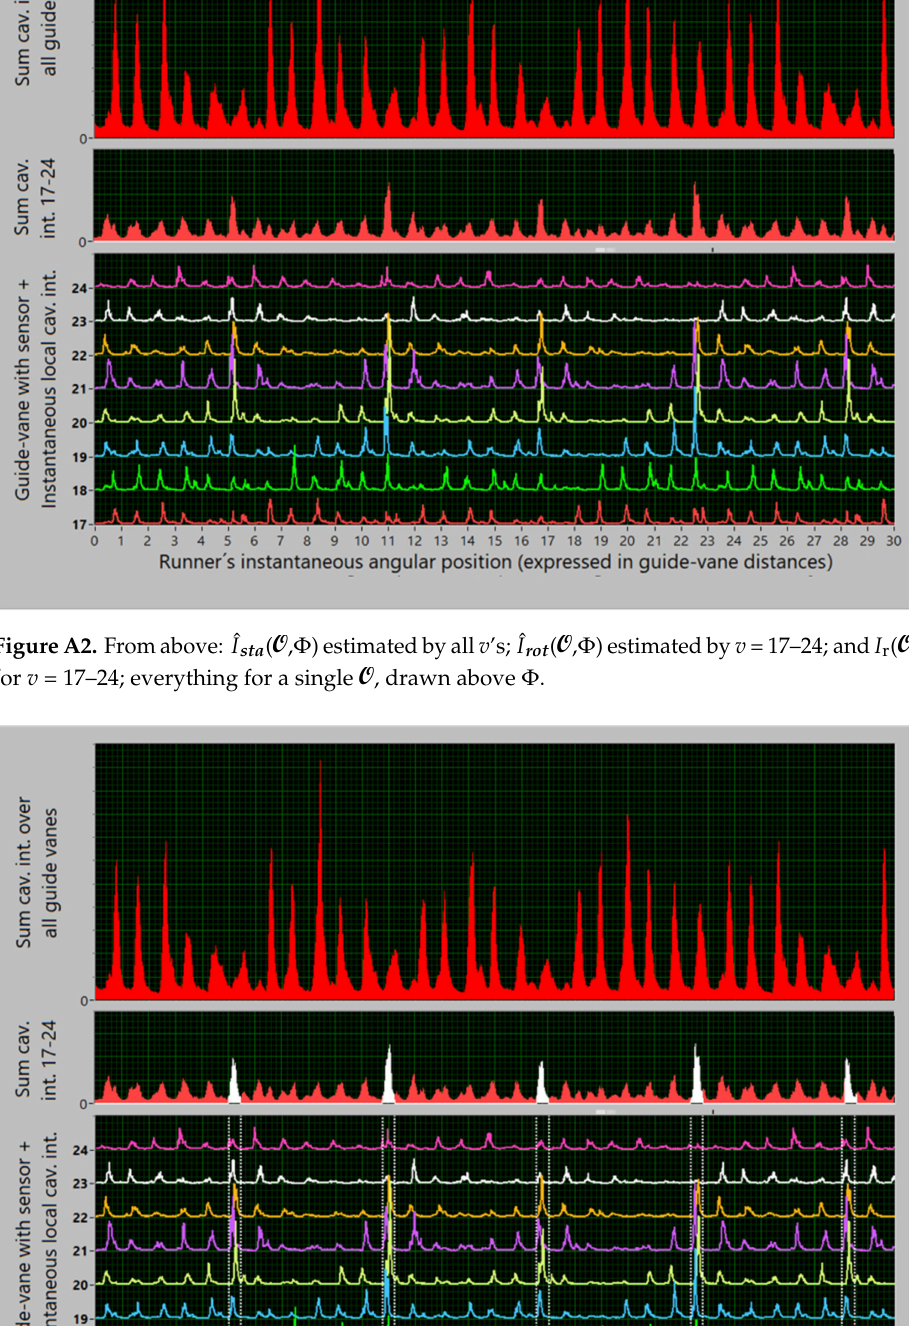
Figure A3. All as in Figure A2 but with denoted limits of filtering in Φ for extracting the rotating mechanism. Note that some further peaks in the vicinity of the filtered range might also be